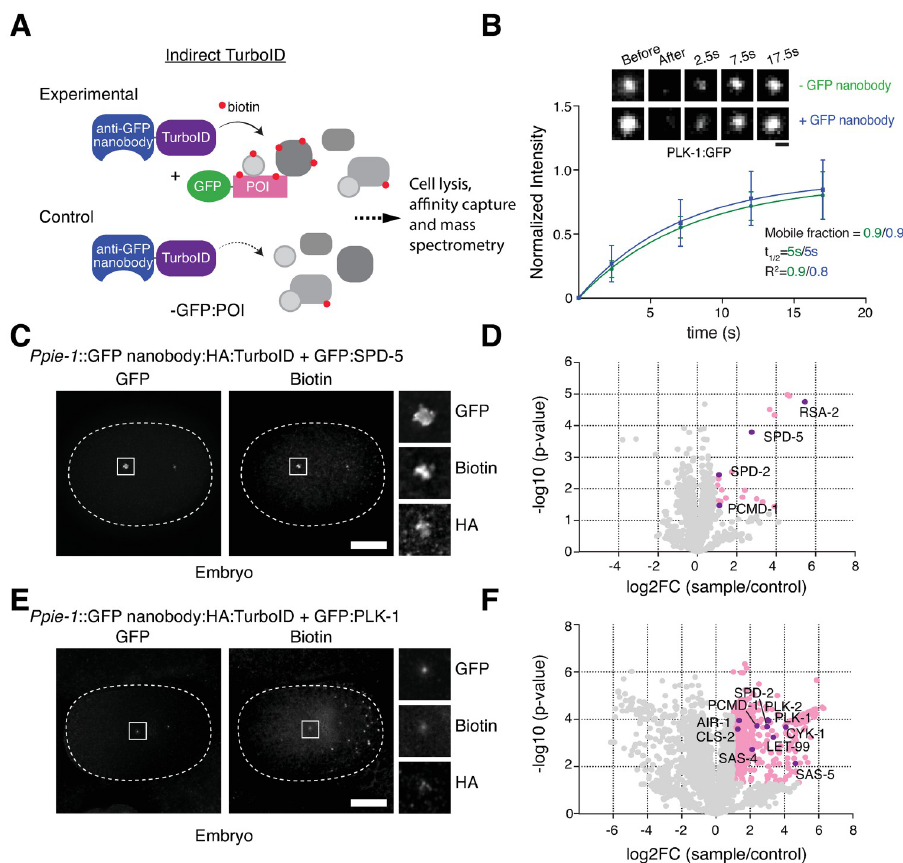
Fig 2. GFP nanobody-directed TurboID as an improved method for proximity-dependent labeling. ( A ) Schematic of indirect TurboID method, whereby the biotin ligase is targeted to an endogenous GFP fusion via a GFP nanobody [41]. Note that experimental and control strains utilize the same TurboID fusion, which may be expressed under a tissue or developmental stage-specific or inducible promoter, while the target protein is potentially expressed in a wide array of tissues and cell types. ( B ) GFP nanobody addition does not perturb PLK-1 mobility. Selected images and quantitation for fluorescence recovery after photobleaching (FRAP) analysis performed on PLK-1:GFP at centrosomes in prometaphase-stage embryos in the presence (n = 16 animals) or absence (n = 13) of the GFP nanobody:TurboID fusion. ( C ) Indirect TurboID applied to SPD-5. Immunofluorescence micrograph of early embryo from strain co- expressing a GFP nanobody:HA:TurboID fusion under the germline promoter pie-1 and endogenously GFP-tagged SPD-5 stained for GFP, biotin (streptavidin) and HA. Biotinylation signal is observed at centrosomes coincident with GFP:SPD-5 and the TurboID fusion. ( D ) Result of LC-MS/MS analysis for indirect TurboID on SPD-5 from mixed- stage embryos. Volcano plot of -log10 p-values against log2 fold change (sample/control). Significantly enriched proteins (Log2 enrichment > 1, p-value < 0.05) are indicated in pink, with selected proteins highlighted. Compare Fig 1D. See also S1 Table and S2E Fig. ( E ) Indirect TurboID applied to PLK-1. Immunofluorescence micrograph of early embryo from strain co-expressing a GFP nanobody:HA:TurboID fusion under the germline promoter pie-1 and endogenously GFP-tagged PLK-1 stained for GFP, biotin (streptavidin) and HA. Biotinylation signal is observed at centrosomes coincident with PLK-1:GFP and the TurboID fusion. ( F ) Result of LC-MS/MS analysis for indirect TurboID on PLK-1 from mixed-stage embryos. Compare Fig 1F. See also S1 Table and S2E Fig. Scale bars are 1 μ m (B), 10 μ m (C,